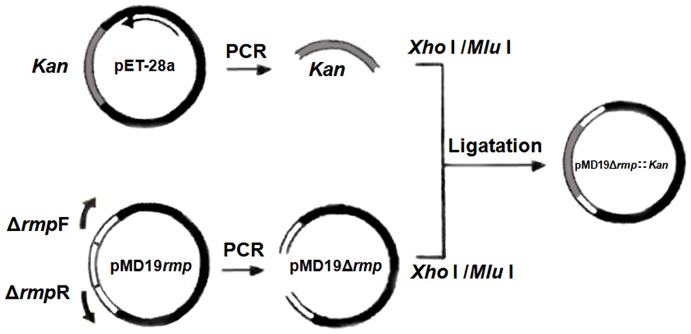
Construction procedure of pMD19▵rmp::Kan.After subcloning Rmp gene in pMD19-T, forward primer was designed in the 3′-flanking region, and reverse primer was designed in the 5′-flanking region. PCR was conducted to obtain DNA fragment pMD19▵rmp with flanking regions in both terminals, which was thereafter connected with Kan gene treated with the same restriction endonucleases, yielding inactivated gene ▵rmp::Kan with the intermediate portion of Rmp gene replaced with Kan gene.